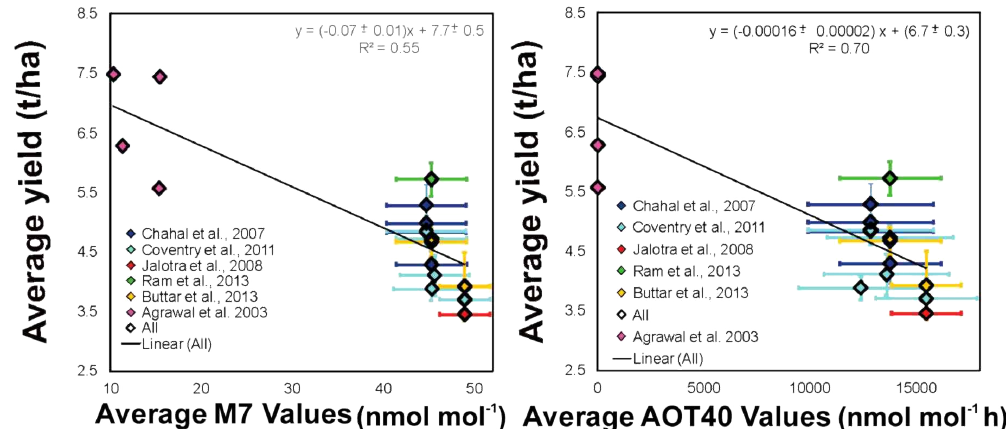
Figure 5. Empirical correlation of wheat yields and ozone exposure indices for field studies with variations in sowing date. Ozone exposure for wheat sown on different dates has been calculated using our data (Table 6). Yield data for wheat have been taken from the peer-reviewed literature (Agrawal et al., 2003; Chahal et al., 2007; Jalota et al., 2008; Coventry et al., 2011; Buttar et al., 2013; Ram et al., 2013). Agrawal et al. (2003) reported co-located measurements of ozone exposure and yields for a number of urban locations that included residential areas and kerb site locations, where NO titration leads to low wintertime ozone levels. Other studies reported yields corresponding to different sowing dates. The yield data have been positioned to conform with the emergence dates (Periods 1 to 5) defined in Supplement S1. Error bars on the x axis show the variance in the ozone exposure metrics for the same growth period (see Supplement S1 for definition) for different years. Error bars on the y axis show the variance in the yield obtained. Variance is introduced by replicating the study on several test plots, in multiple years or varying growing conditions and by the number of irrigations and or the tillage